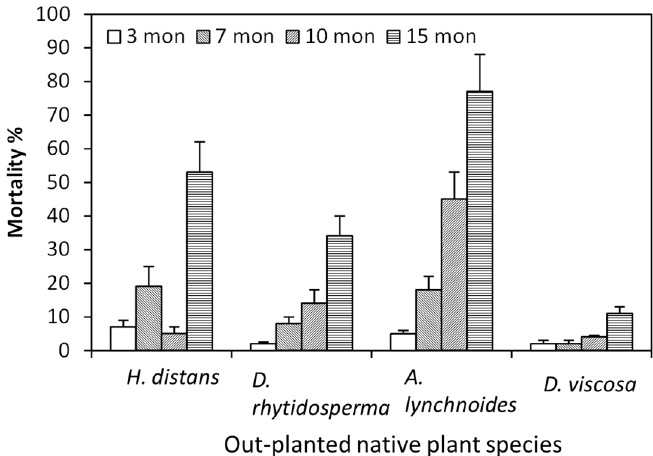
Figure 4. Mortality of out-planted native species Kauai hau kuahiwi ( Hibiscadelphis distans ), Kauai delissea ( Dellissea rhytidosperma ), kawawaenohu ( Alsinidendron lynchnoides ) and aalii ( Dodonaea viscosa ) at Kalalau Rim site (Site I) 3, 7, 10 and 15 MAP.